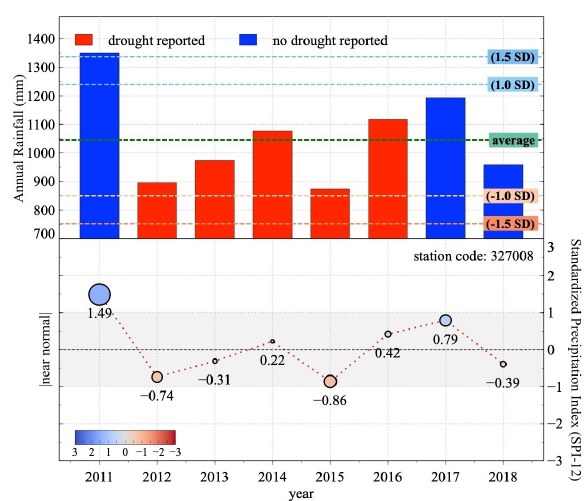
Fig. 10. Interpretation of SPI12 as drought indicator with the amount of annual rainfall and drought information at station TMD